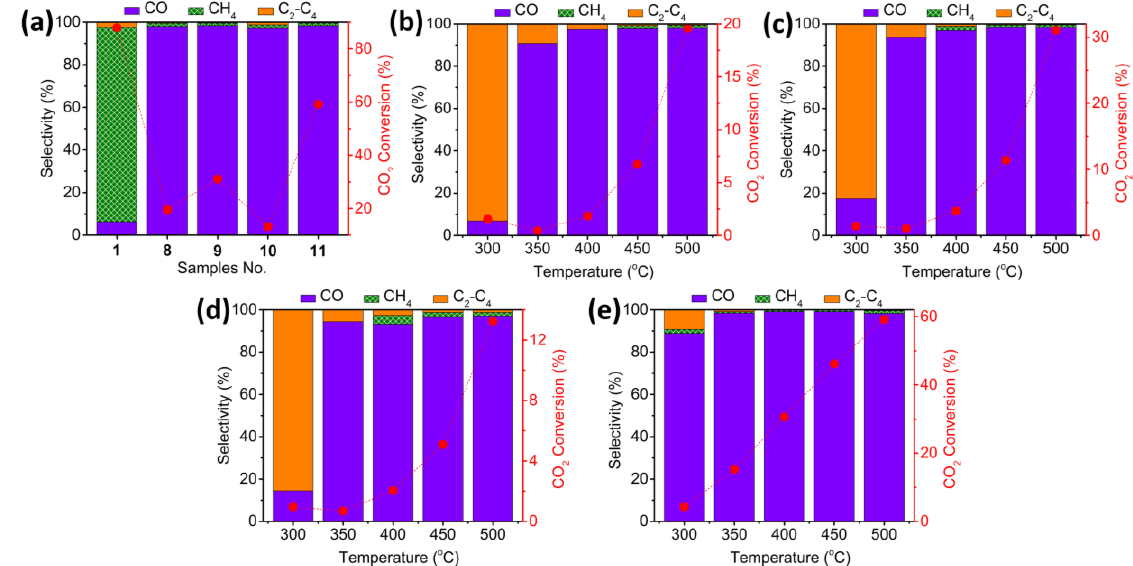
Figure 6. CO 2 conversion and selectivity for samples 1 and 8 – 11, with different contents of S ( a ) at 500 °C and ( b – e ) at different temperatures. ( b ): Sample 8; ( c ): sample 9; ( d ): sample 10 and ( e ): sample 11. Reaction condition: H 2 /CO 2 ratio of 7, total flow 4 mL/min, 10 bar, 40 mg catalyst. The error of the measurements is lower than 10%.